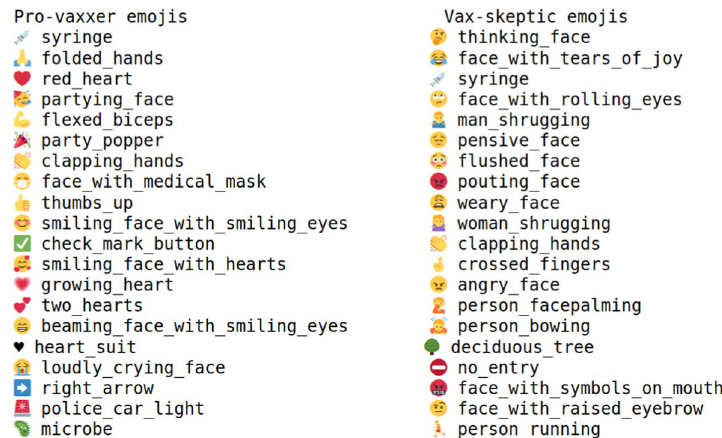
Fig. 8 Popular emojis for pro-vaxxer (left) and vax-skeptic (right) tweets